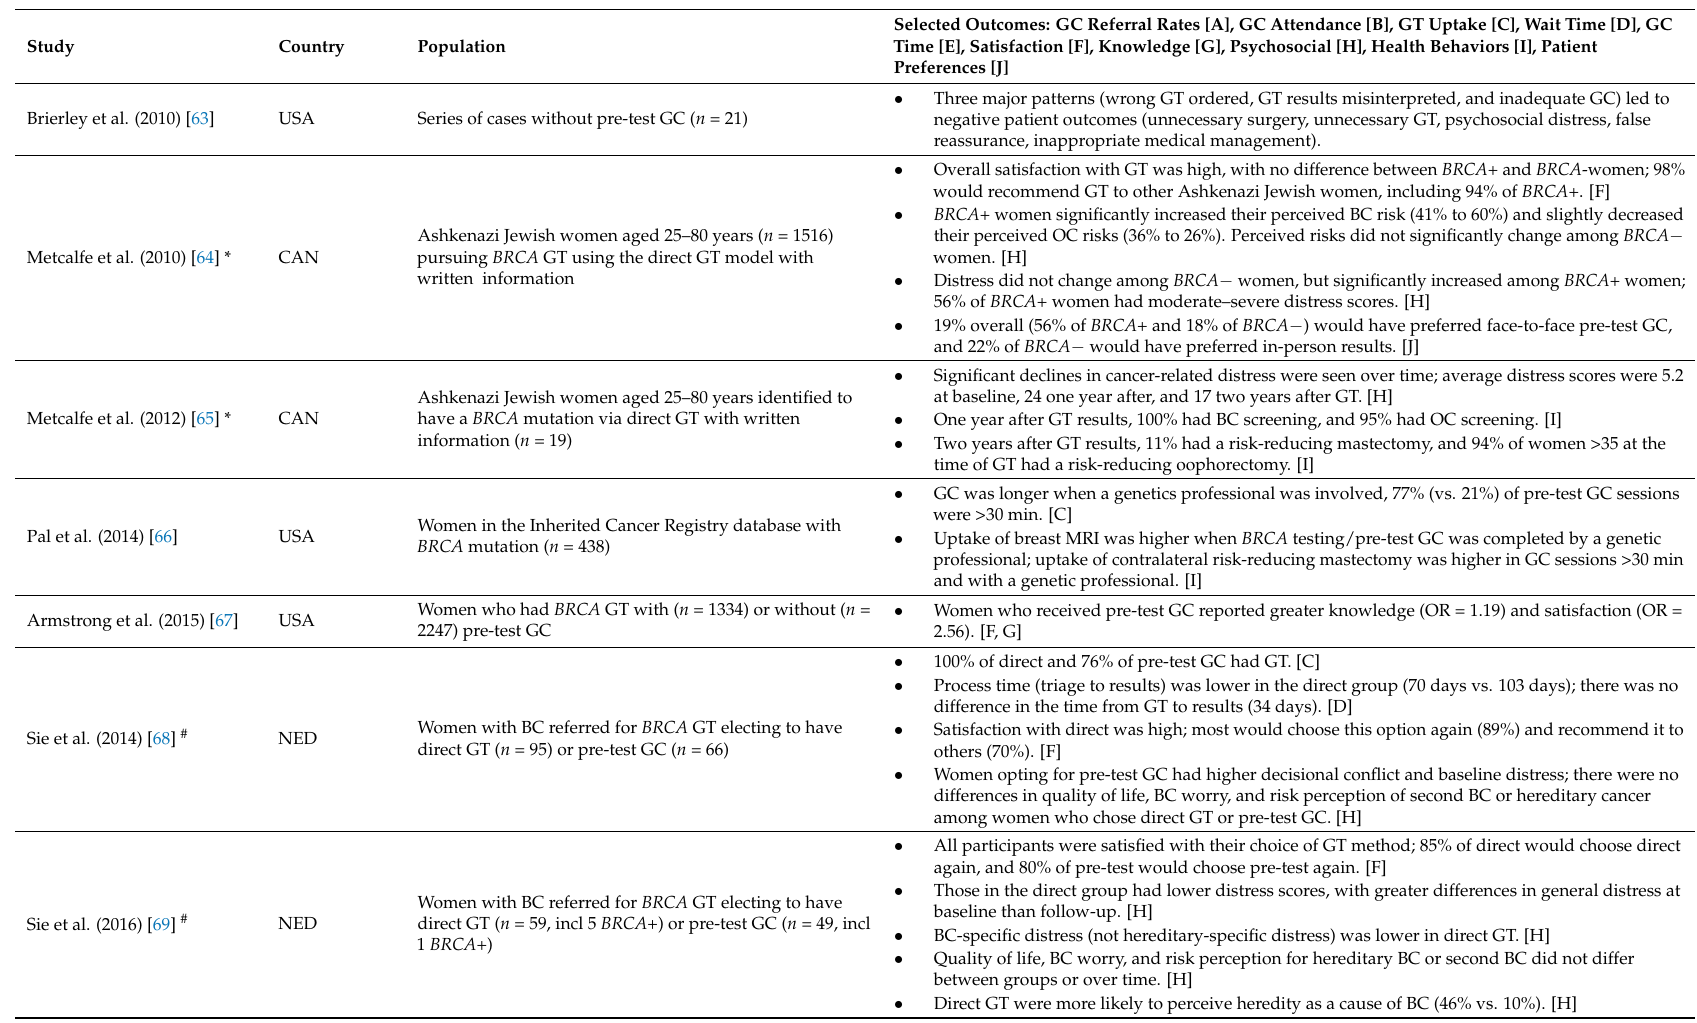
Table 6. Direct genetic testing